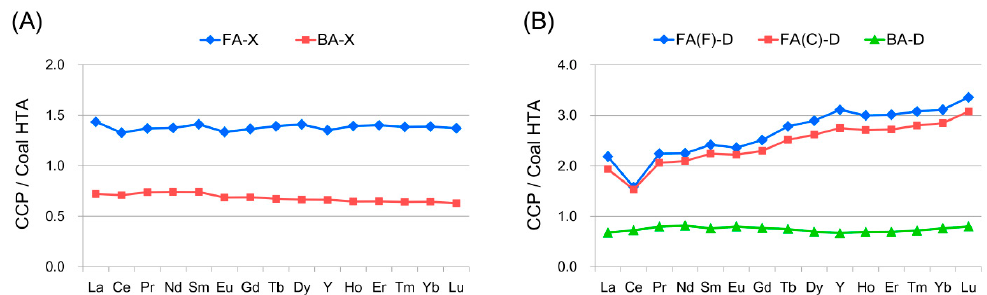
Figure 12. Distribution patterns of REY in CCPs (ash basis; on average) from the Xilaifeng ( A ) and Damo ( B ) power plants. REY concentrations are normalized to laboratory coal ashes.